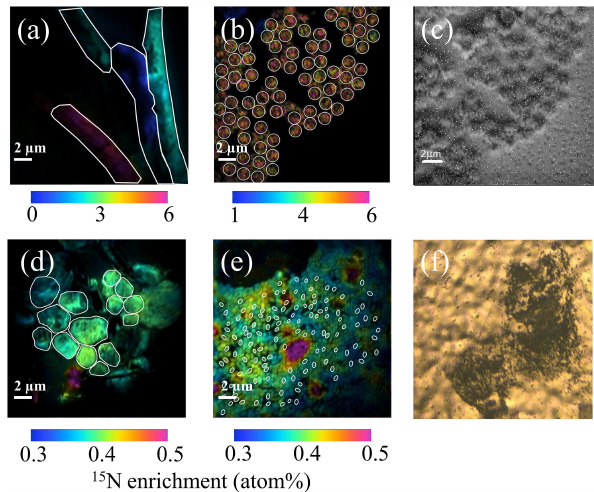
Figure 1. NanoSIMS images showing the 15 N enrichment (a, b, d, e) after 48h of incubation in the presence of 15 N 2 for Trichodesmium (a) , UCYN-B (b) , nano-eukaryotes (d) and Synechococcus (e) . The ROIs are represented with white lines. NanoSIMS images showing the secondary electron channel of UCYN (c) and optical camera image of Prochlorococcus spotted on the filter before NanoSIMS analyses (f)